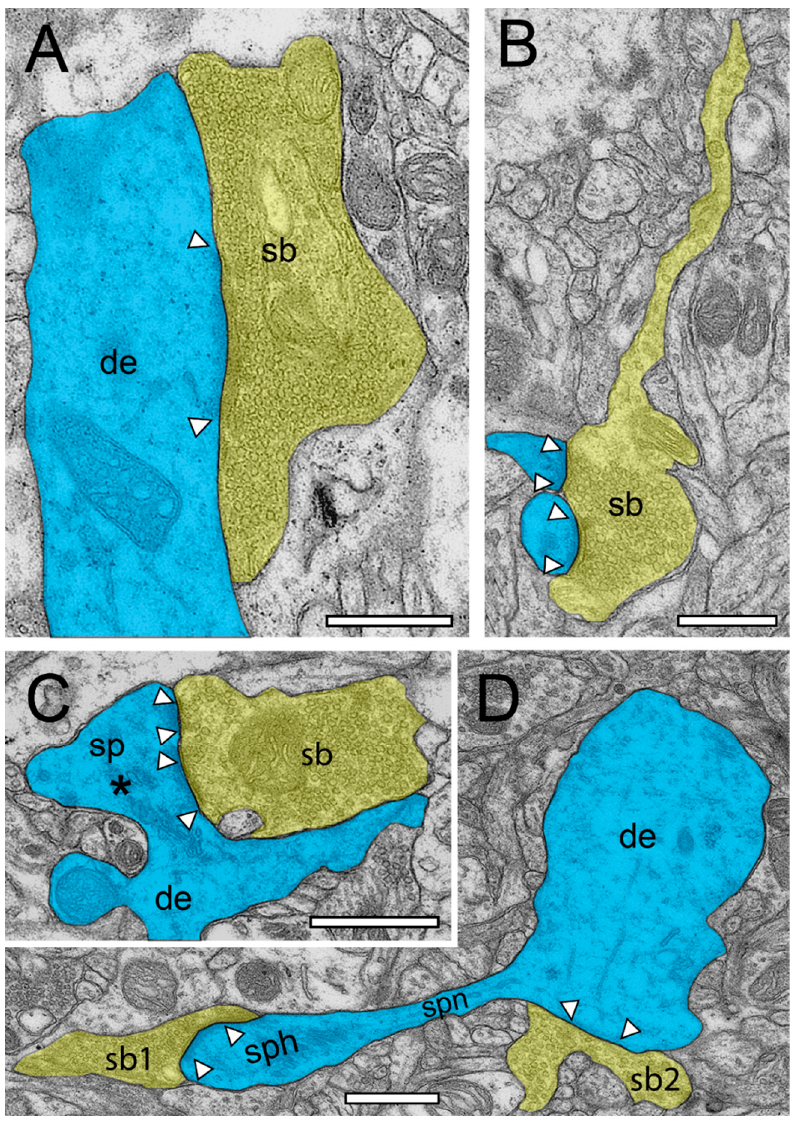
Figure 4. Structural characteristics of SBs and their target structures in the human TLN as revealed by TEM. ( A ), Large putative inhibitory (sb, transparent yellow) terminating on a large dendrite (de, transparent blue) in L2 of the gyrus temporalis inferior with a large macular, non-perforated AZ (arrowheads) containing thousands of SVs. ( B ), Typical example of an axonal segment, giving rise to an end terminal SB (sb) innervating two adjacent small dendritic spines with relatively small AZs (arrowheads) in L3 of the gyrus temporalis inferior. Note the appearance of SVs also in the axon. Same color code as in A. ( C ), End terminal SB (sb) synapsing on a large stubby spine (sp) with a large spine head emerging directly from a dendrite (de) in L6 of the gyrus temporalis medialis. Note the two AZs (arrowheads) and the large spine apparatus (asterisk) in the spine head. Same color code as in ( A ). ( D ), A small dendritic segment (de) giving rise to an elongated spine with a small spine neck (spn) leading to a large spine head (sph). Two SBs (sb1, sb2) terminate directly on the spine head (sb1) and on the dendrite (sb2). AZs are marked by arrowheads. Same color code as in ( A ). Scale bar in ( A – D ), 0.5 µm.